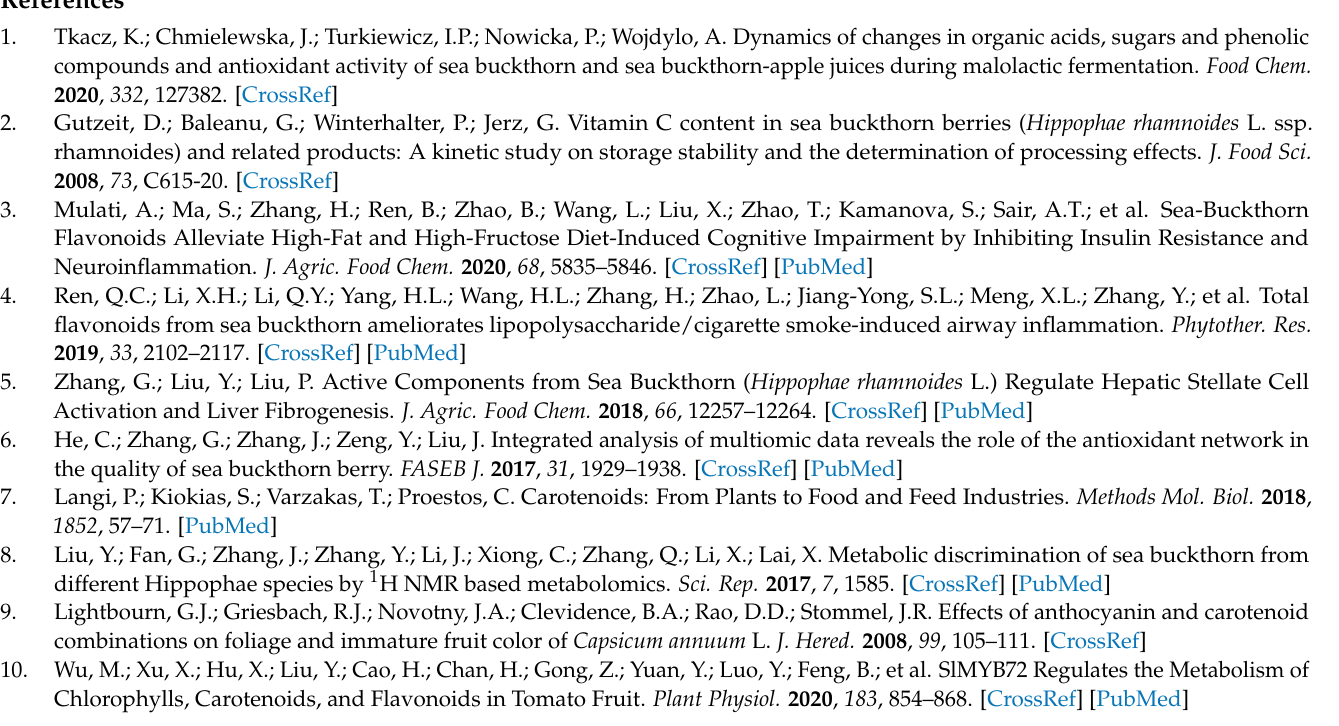
boxplot. Figure S2: Gene expression distribution boxplot. Figure S3: Relationships among the modules. Figure S4: Heatmap of FPKM and GO and KEGG scatterplot of module genes. Table S1: Flavonoids identified in five sea buckthorn fruits. Table S2: Differentially accumulated flavonoids identified in five sea buckthorn fruits. Table S3: Raw data, clean data, and mapped data. Table S4: The WGCNA gene modules. Table S5: Gene number of WGCNA modules. Table S6: Gene FPKM values in several modules. Table S7: GO and KEGG annotations of genes in